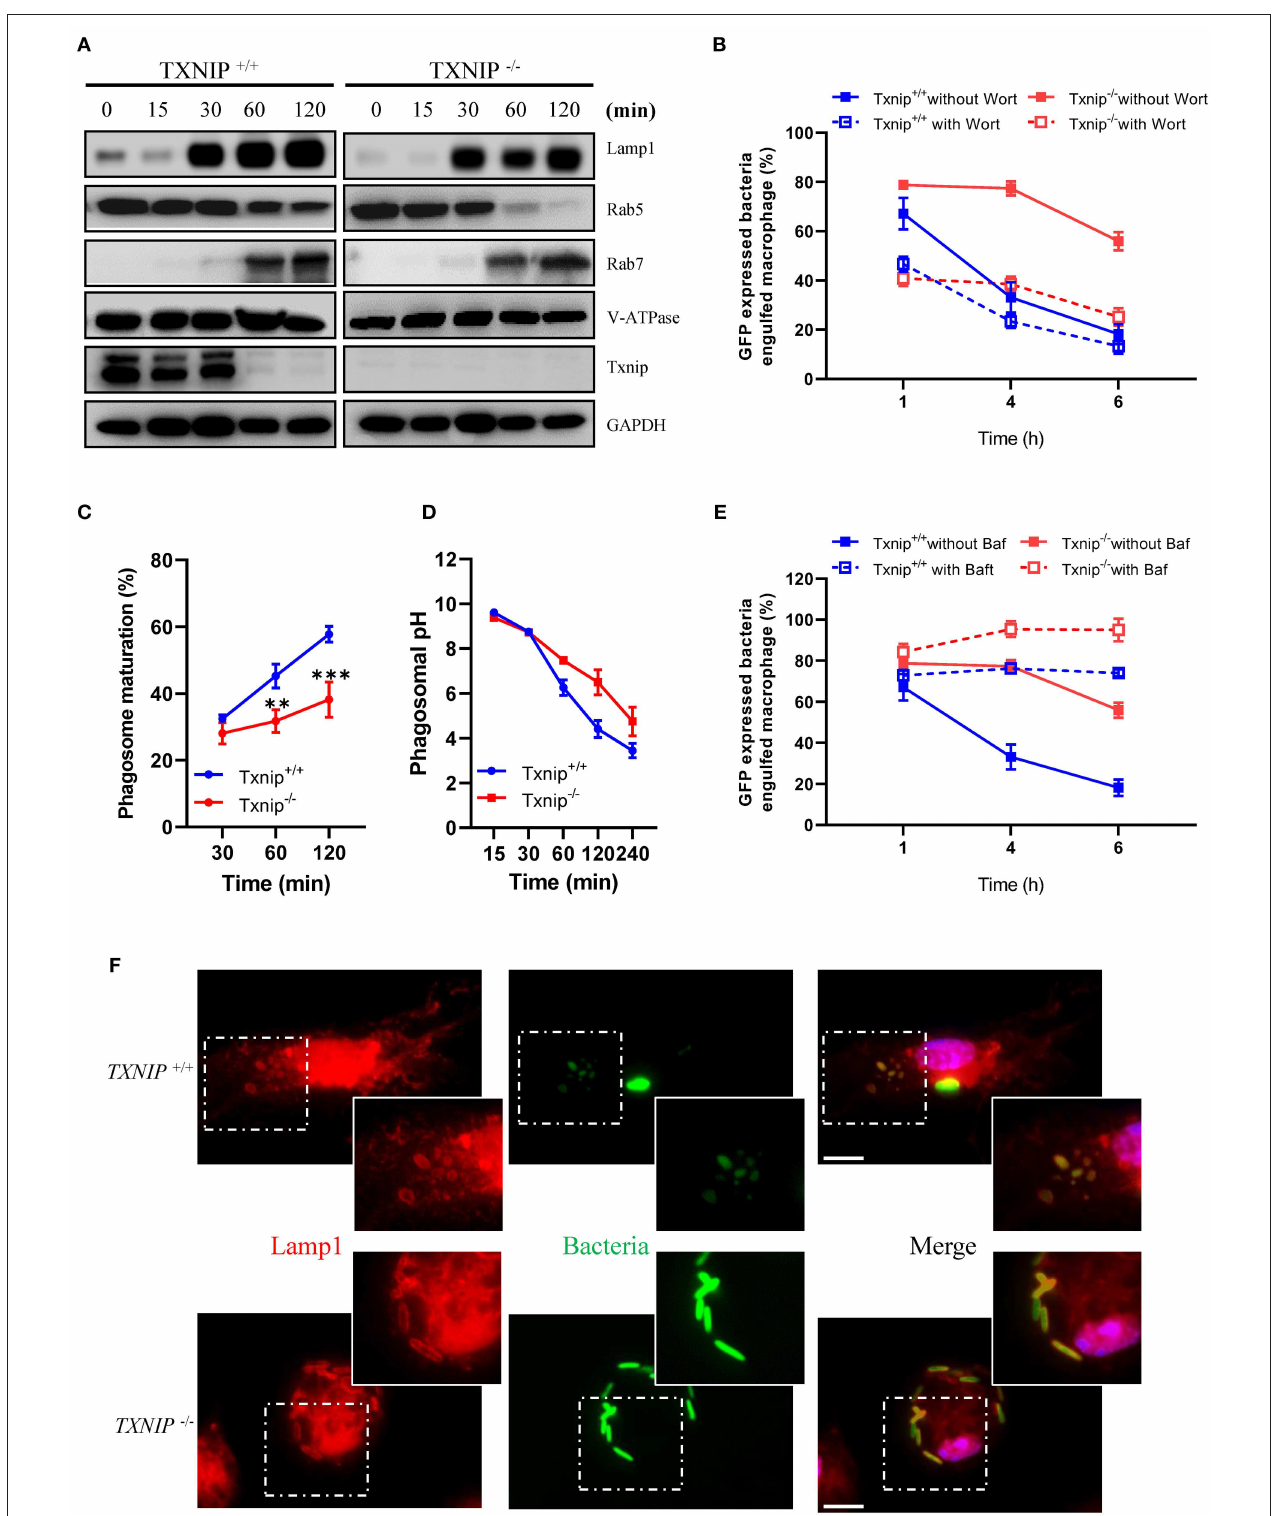
FIGURE 2 | Thioredoxin-interacting protein (TXNIP) controls the acidification of phagosomes in macrophages after the engulfment of bacteria. (A) The expression of proteins related to phagosome maturation in phagosomes isolated from wild-type (WT) and Txnip knockout (KO) mouse peritoneal macrophages after treatmentwith E.coli fortheindicatedtimes. (B) TheproportionofWTand Txnip KOperitonealmacrophages,treatedwithorwithoutwortmannin(10 µ M),whichretained